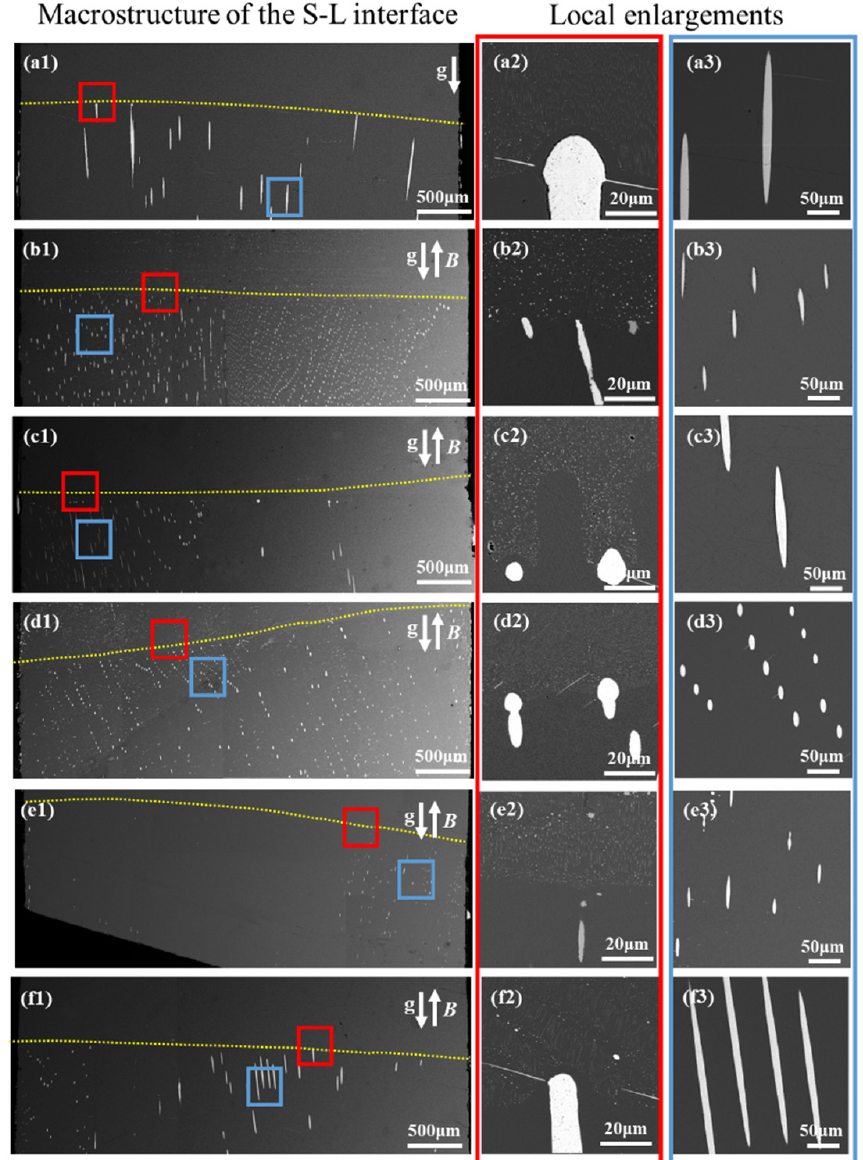
Figure 1. The morphology of the S-L interfaces and microstructures of ingots directionally solidified at a growth rate of 1 µ m/s under various MFDs. ( a1 – a3 ) 0 T; ( b1 – b3 ) 0.1 T; ( c1 – c3 ) 0.5 T; ( d1 – d3 ) 1 T; ( e1 – e3 ) 3 T, ( f1 – f3 ) 5 T. The yellow dotted lines are used to show the S-L interfaces. Figure 3 shows the fiber spacings on the transverse sections of ingots directionally solidified under various MFDs at growth rates of 1 µ m/s and 5 µ m/s, respectively. The trends of fiber spacings vary with the MFD are exactly opposite for the cases. For the